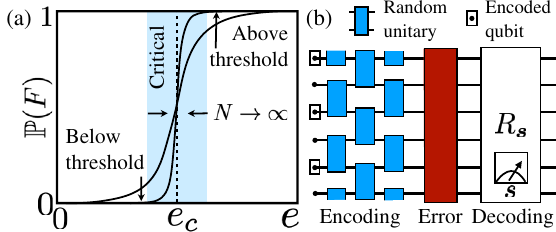
FIG. 1. (a) Probability of decoding failure P ð F Þ vs error rate e through an error-correction threshold for an optimal code. In this work, we probe the optimality of a given code ensemble by comparing the location and universality class of the critical point to random stabilizer codes. (b) Illustration of the models we study. The encoding circuit is a low-depth random unitary circuit, and the error is an erasure of a fixed fraction eN of N qubits. The decoding proceeds via generalized measurements with outcomes s and recovery operators R . We mostly focus on stabilizer codes, s where optimal decoding of Pauli error channels like erasure errors is possible with stabilizer syndrome measurements, followed by the conditional application of single-site Clifford